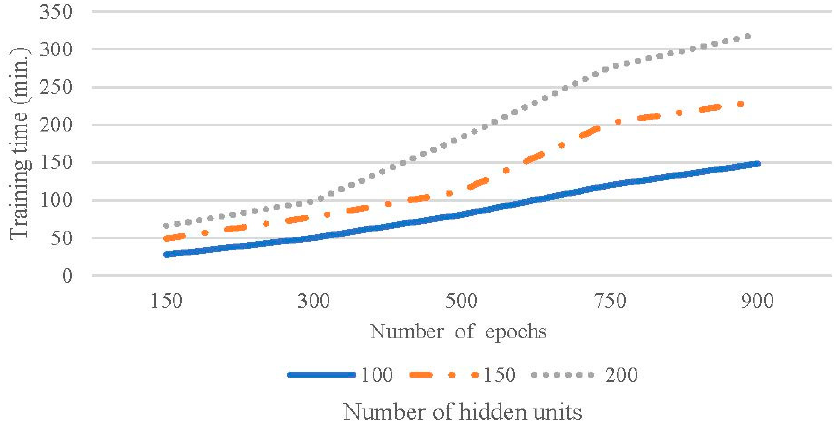
Figure 6. Training time results for the number of hidden units and epochs.